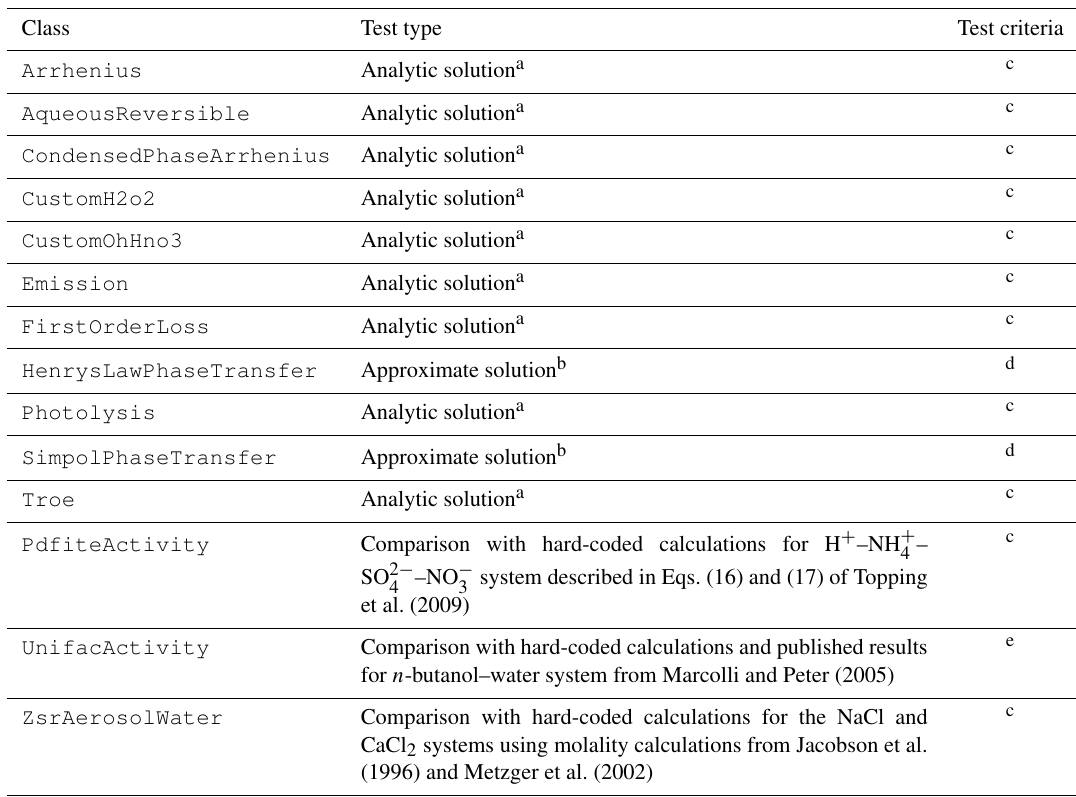
Table 7. Tests applied to Process and Parameter subclasses.